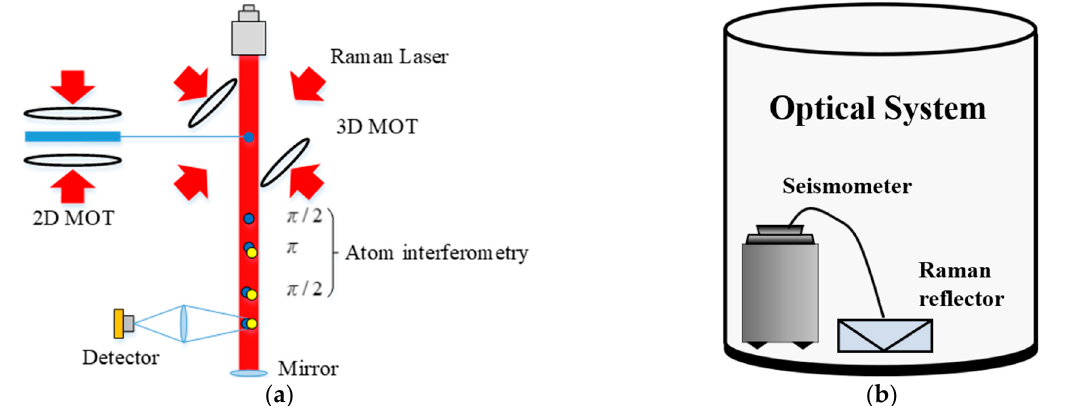
Figure 4. Atomic gravimeter’s optical system. ( a ) Atomic interference with the reflector located at the bottom to reflect Raman lights. ( b ) Inside the optical system, in which the seismometer was placed in the test to respond to the vibration of the reflector in an accurate and sensitive way.